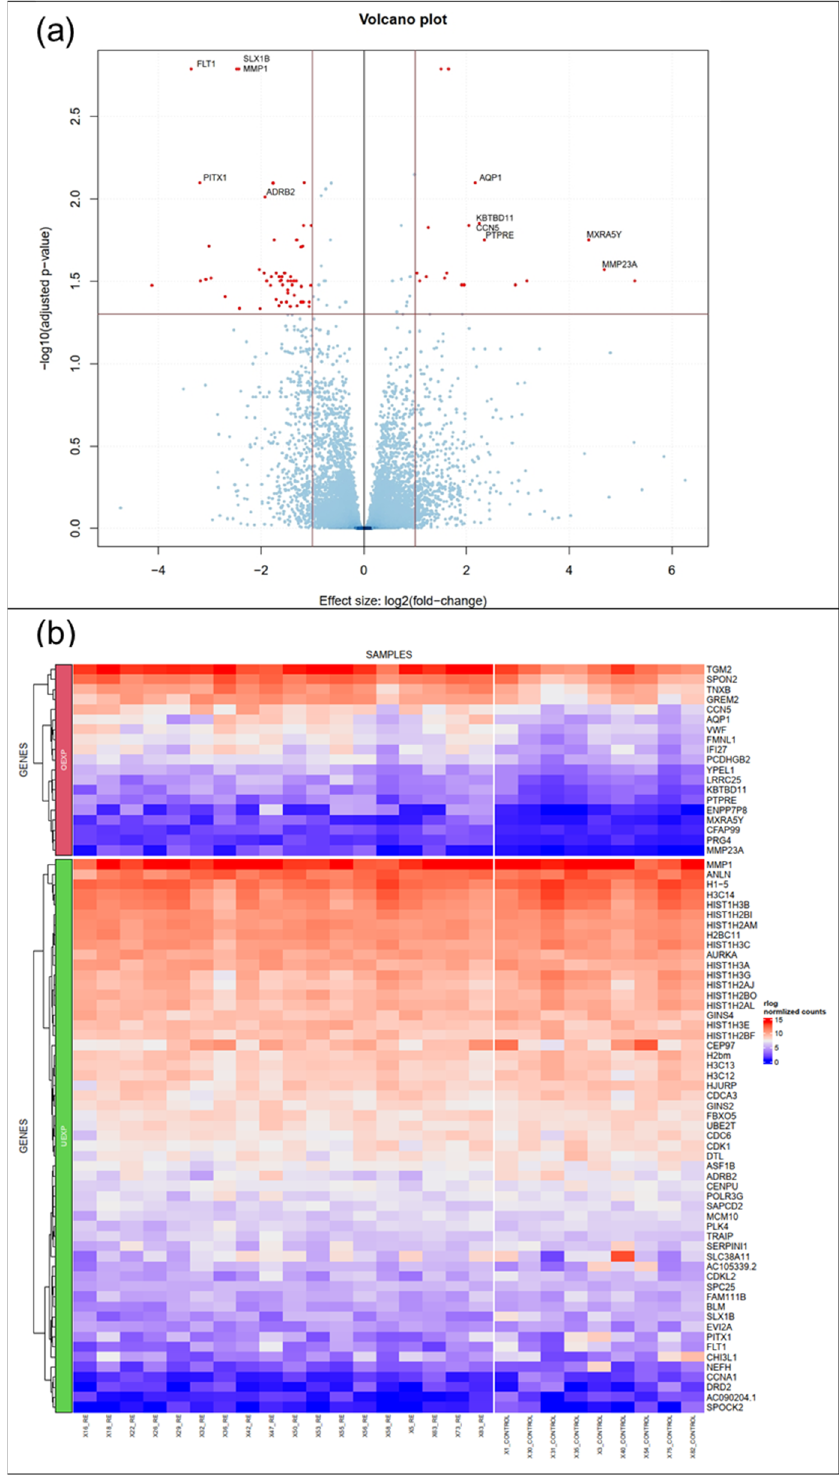
Figure 1. RNA-seq/ DESeq2 analysis revealed 74 differentially regulated genes. ( a ) Volcano plot summarizing the expression profile of healthy(control) VFF vs RE VFF ( b ) Heat map showing significantly upregulated (upper panel, overexpressed OEXP)/ downregulated genes (lower panel, underexpressed UEXP) with a log2FC above 1/ below − 1 and an adjusted p -value below 0.05, further reduced by mitochondrial genes. Controls: n = 9, RE: n =